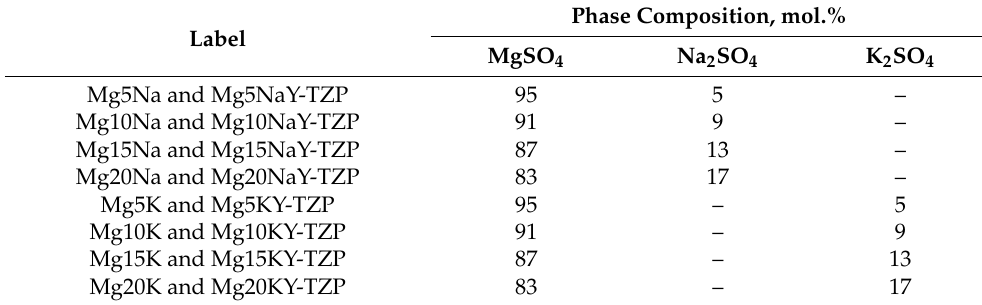
Table 1. Sample abbreviations and phase